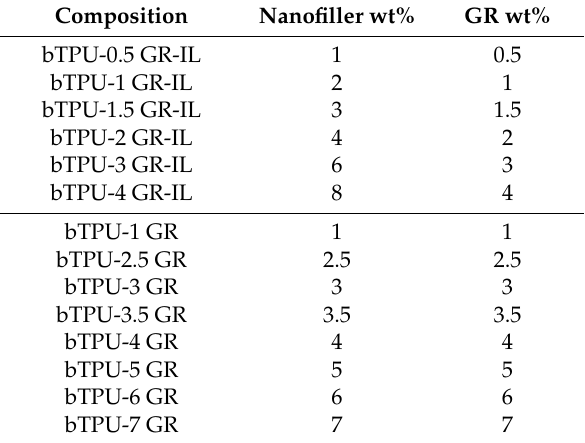
Table 1. Prepared biobased thermoplastic polyurethane (bTPU) polymer nanocomposites (NCs) and their total nanofiller and graphene (GR) contents. Composition Nanofiller wt% GR wt% bTPU-0.5